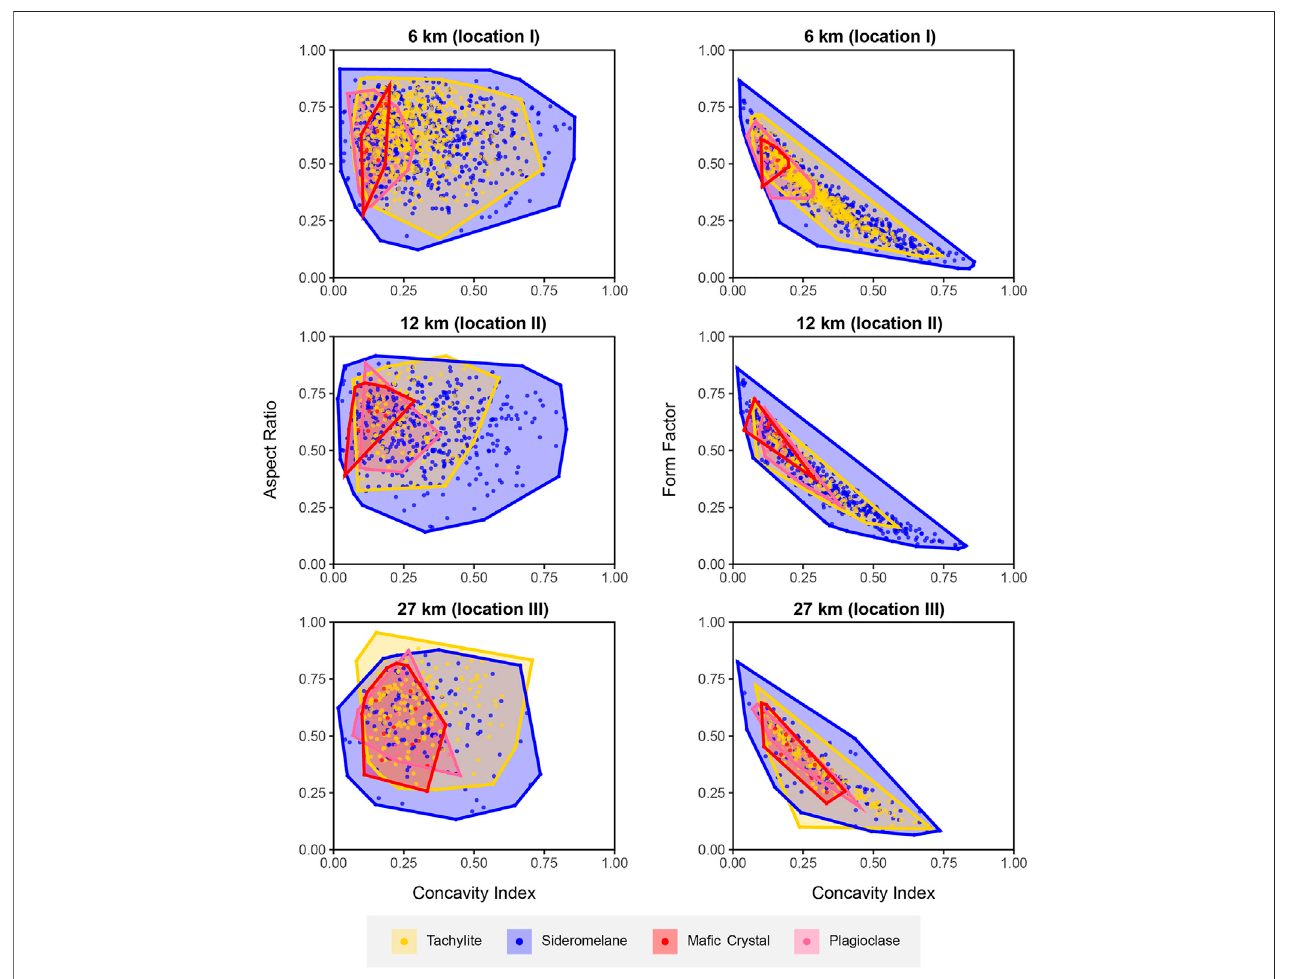
FIGURE7| AspectRatiovs.ConcavityIndexandFormFactorvs.ConcavityIndexforthedifferenttexturalcomponentrygroupsinthe125 – 180 µmsizefractionat differentdistancesfromvent.ParametersmeasuredbySEMimageanalysis.Theconvexhullsofeachscatterplotseparatedbycomponentrygroupsarerepresentedby the thick contours and shaded